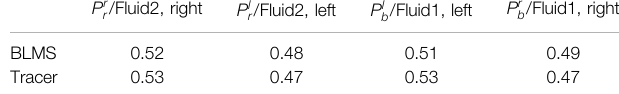
P r r /Fluid2, right P l